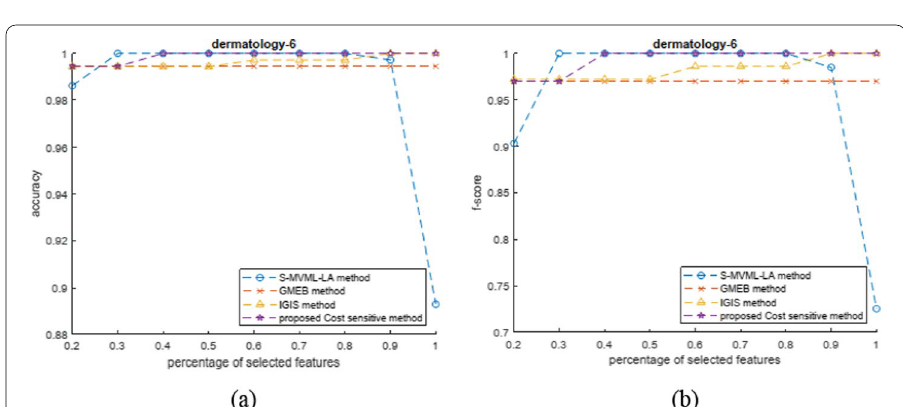
Fig. 3 The performance of the proposed cost sensitive method, S-MVML-LA [15], GMEB [10] and IGIS [20] versus the changes in percentage of selected features numbers on the deramatology-6 dataset. a Accuracy,